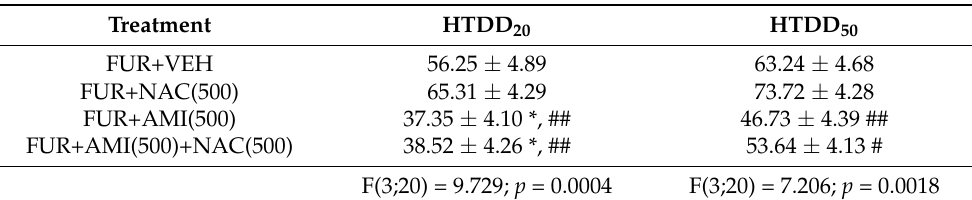
Table 2. Influence of FUR, AMI and NAC on the reduction in hearing threshold in animals receiving the drugs either alone or in